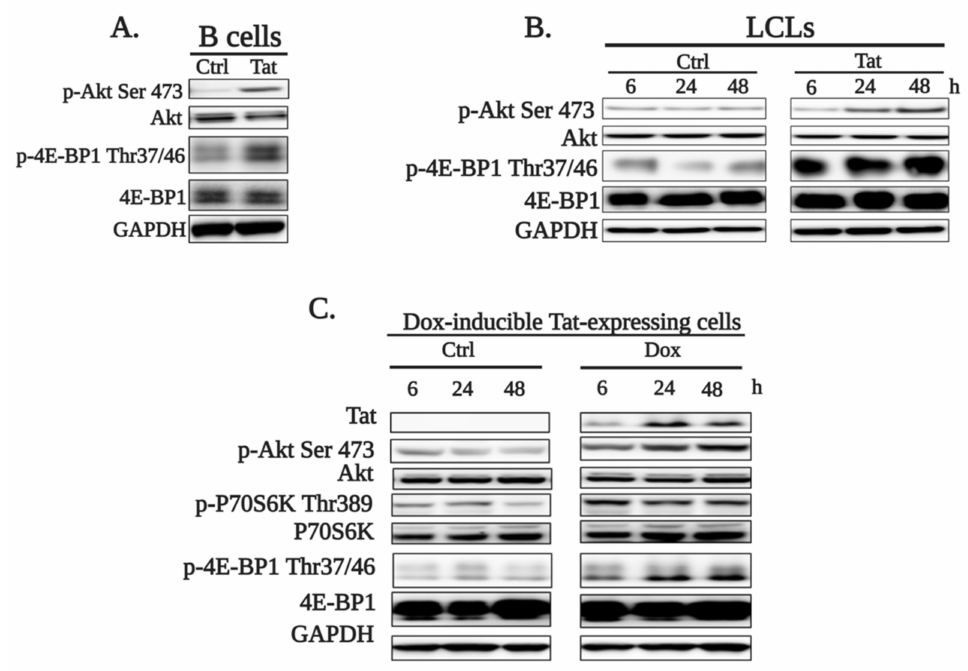
Figure 2. HIV-1 Tat activates the Akt/mTORC1 pathway in B cells. ( A ) Primary B cells purified from the blood of healthy donors were left untreated (Ctrl) or treated (Tat) with 250 ng/mL Tat for 48 h. ( B ) Immortalized lymphoblastoid cell lines (LCLs) were treated with 250 ng/mL Tat for 6, 24 and 48 h. ( C ) Tat expression was induced (Dox) in doxycycline-inducible Tat-expressing RPMI-8866 cells by treating with 1 µ g/mL doxycycline for 6, 24 and 48 h. Tat, Akt and its phosphorylated form (p-Akt Ser473), P70S6K and its phosphorylated form (p-P70S6K Thr389) and 4E-BP1 as well as its phosphorylated form (p-4E-BP1 Thr 37/46) were detected by Western blotting with specific antibodies. GAPDH was used as the loading control. Representative images of three independent experiments are shown. The image quantification and statistical analysis are shown in Figure